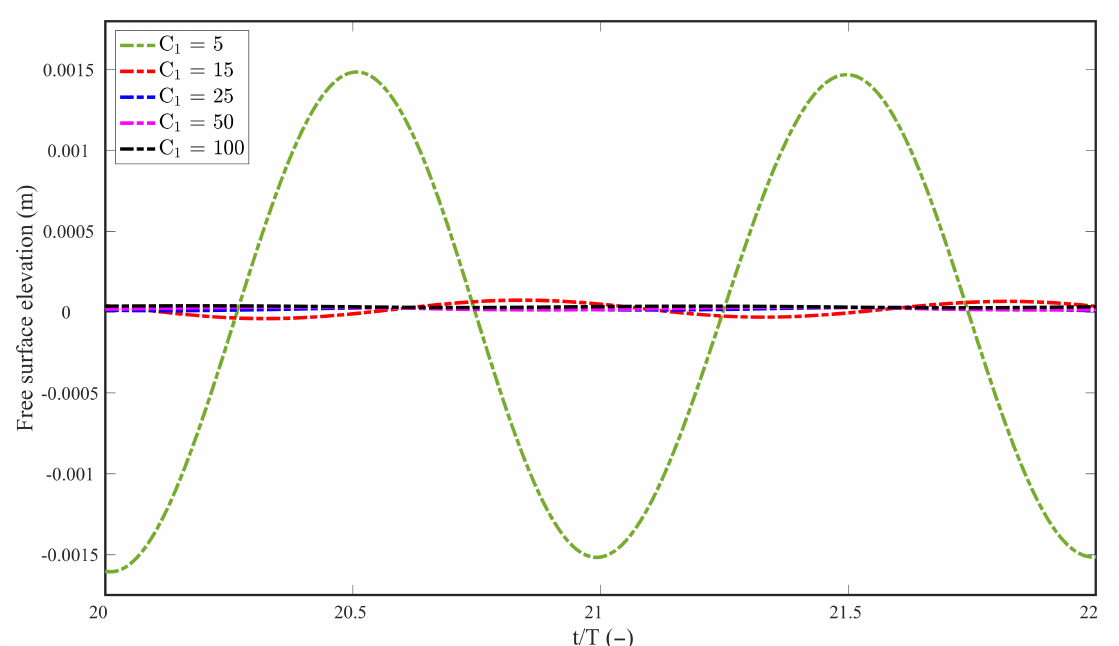
Figure 11. Comparison of free surface elevation at the end of the channel, according to the values adopted for numerical beach coefficient C 1 .